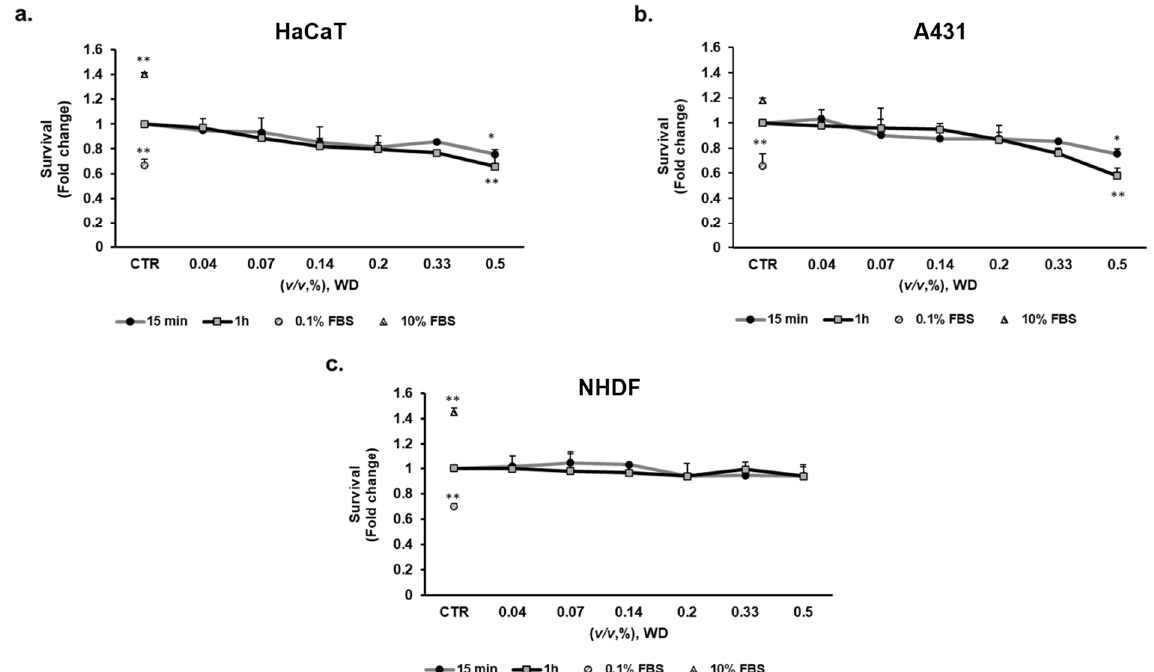
Figure 2. Effect of WD on cell viability, evaluated by the MTT test: short exposure. Keratinocytes HaCaT ( a ), model of mucosal epithelial cells A431 ( b ) and fibroblasts NHDF ( c ) were exposed to increasing concentrations of WD (0.04–0.5%, v / v ), under experimental condition of medium with 1% FBS for 15 min and 1 h. Viability was measured after 18 h of incubation in fresh medium by MTT test. Survival data were calculated as 540 nm relative absorbance/well. Data in the graphs are reported as fold change (means ± SD), giving 100% to the control condition (CTR: medium with 1% serum). (n = 3). * p < 0.05, ** p < 0.01 vs. untreated cells.